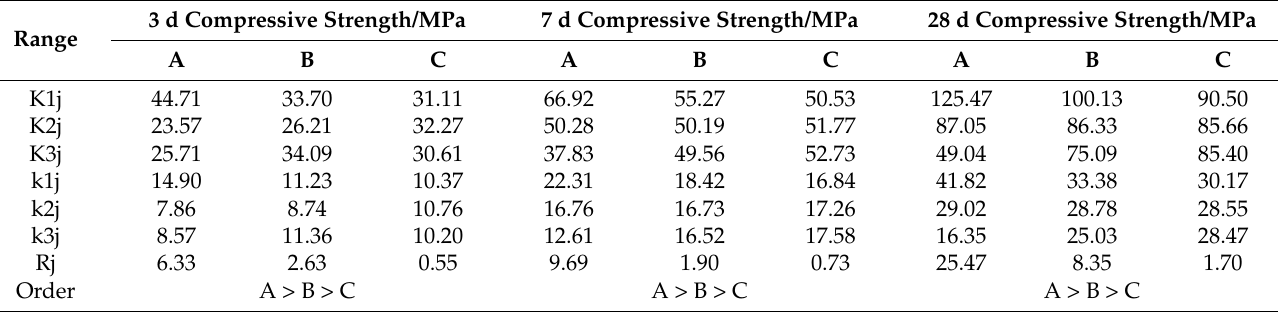
Figure 8. Compressive strength test results. Table 7. Analysis of the range of test results by various